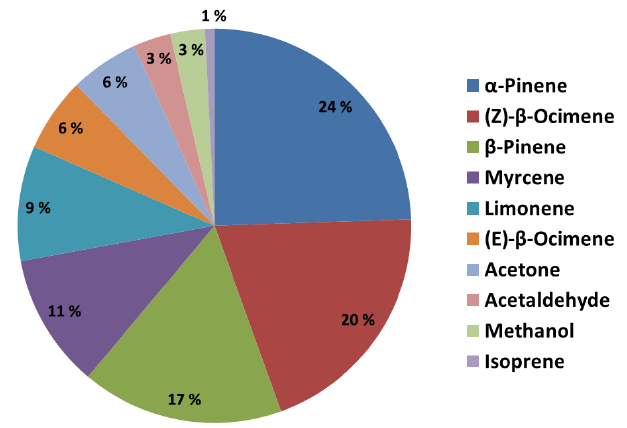
Figure 6. BVOC composition of six Quercus ilex trees. BVOC pat- tern was measured with GC-MS/FID in SAPHIR during the ozonol- ysis experiment described in Sect. 3.6. The relative contribution of each compound concentration (ppbv) is shown.